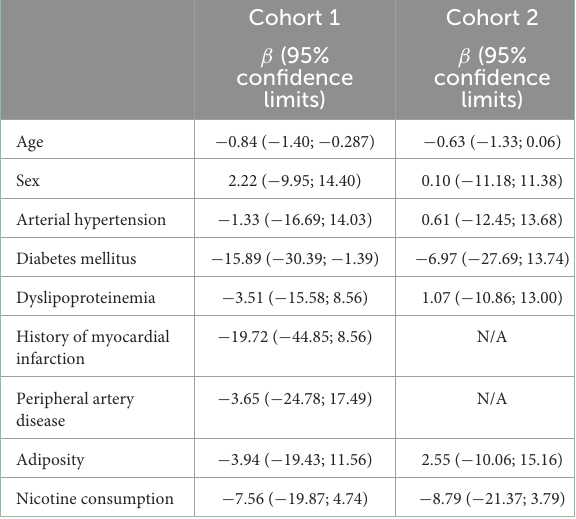
TABLE 4 Multivariable linear regression models estimating the effect of distinct vascular risk factors on ADAMTS-13 activity in cohorts 1 and